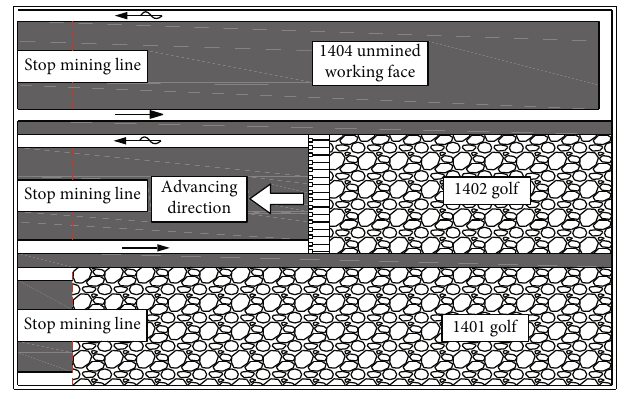
Figure 1: Schematic layout diagram of 1402 working face.